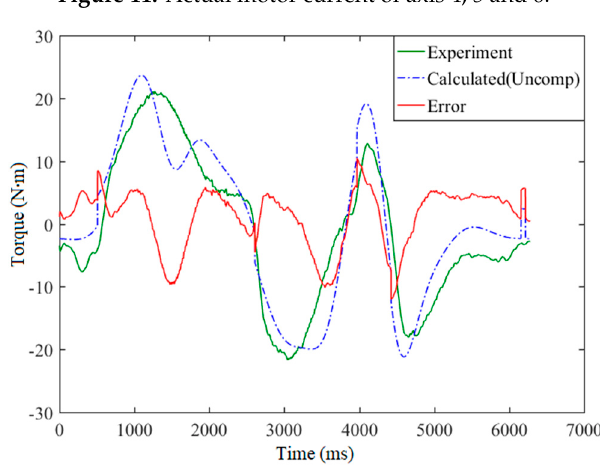
Figure 12. Computed torque (uncompensated), actual and error torques of axis 5.